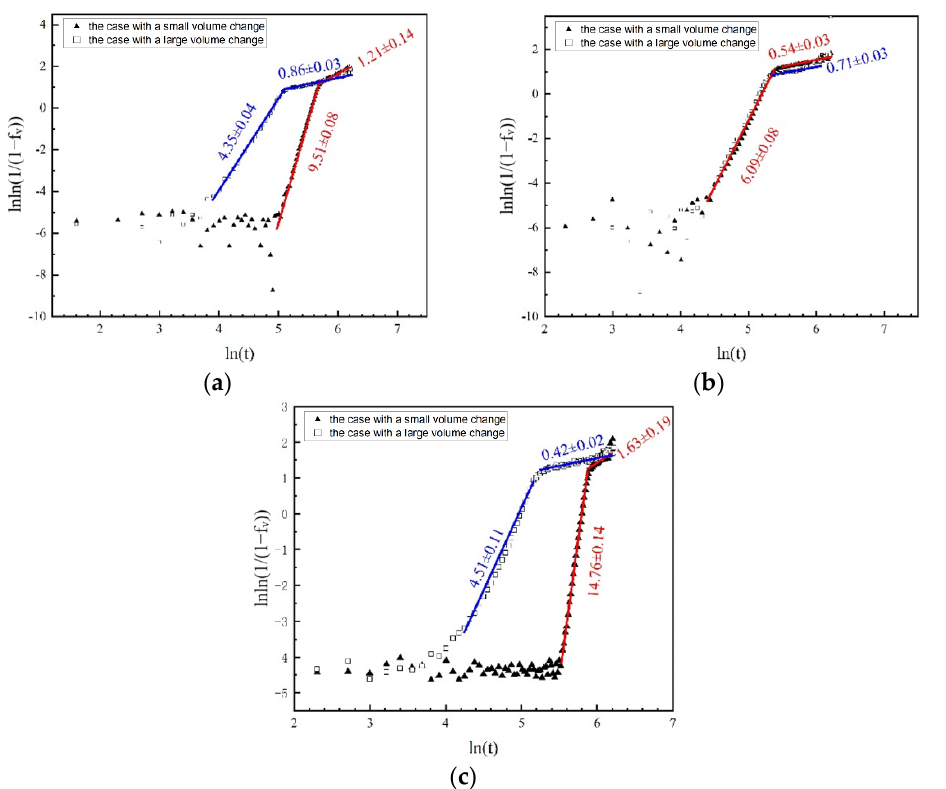
Figure 7. Grain growth kinetics curve of the isothermal solidification process with different cooling rates. ( a ) 2.0 × 10 11 K/s, ( b ) 2.0 × 10 12 K/s, ( c ) 2.0 × 10 13 K/s.